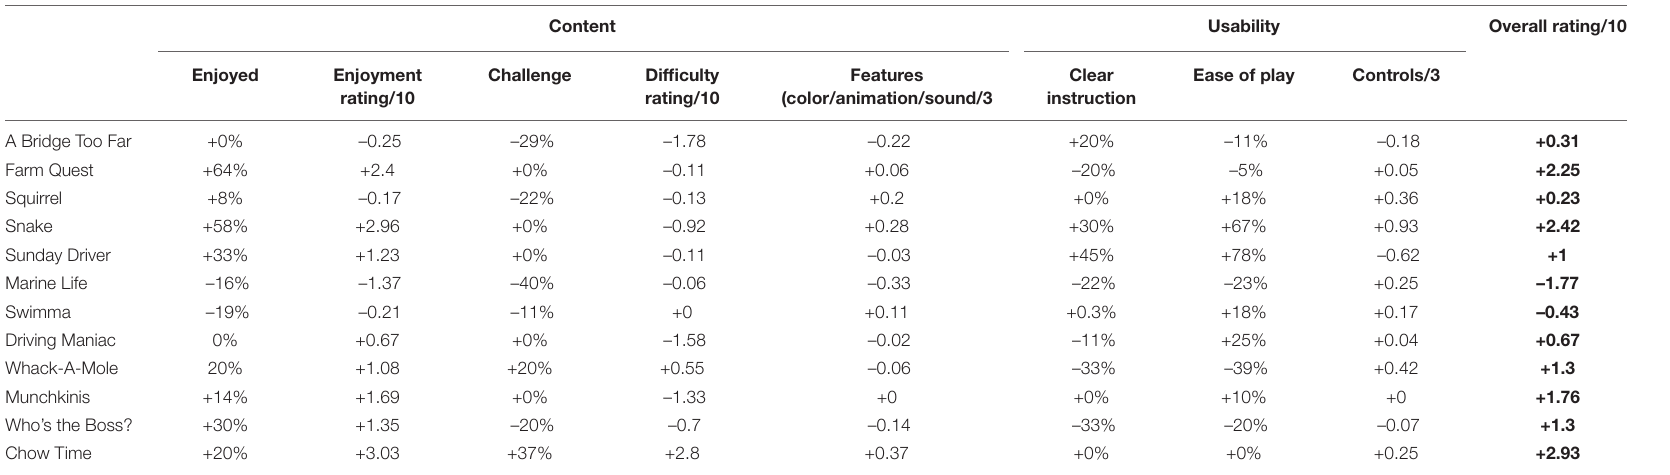
TABLE 7 | Absolute increase/decrease from baseline for each individual games following